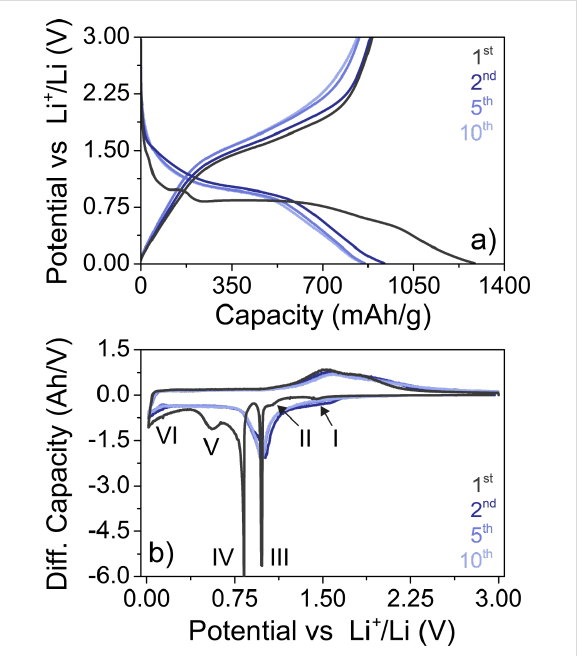
Figure 8: (a) Charge/discharge profiles and (b) corresponding differen- tial capacity curves of ZFO nanoparticle electrodes in Li half-cells. The first two cycles were performed at C/20 and then the rate was in- creased to C/10 for the subsequent cycles. The Roman numbers in (b) indicate different electrochemical reactions in the initial